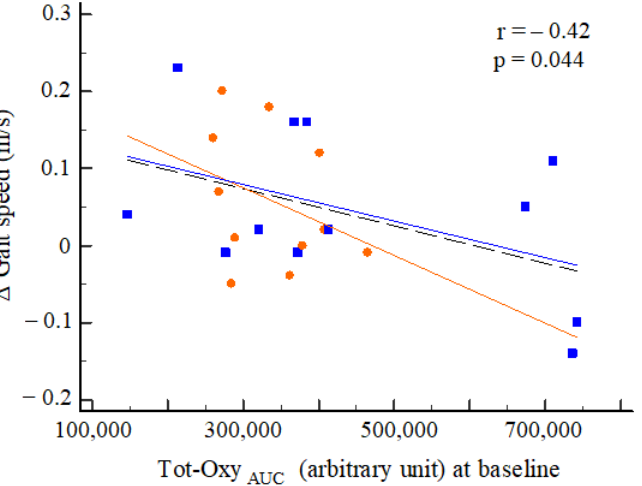
Figure 6. Correlation between cortical activation at baseline and variations in gait speed after rehabilitation among the two groups (OW: orange; RAGT: blue). Legend: tendency lines: orange, OW; blue, RAGT; black dashed, the whole population